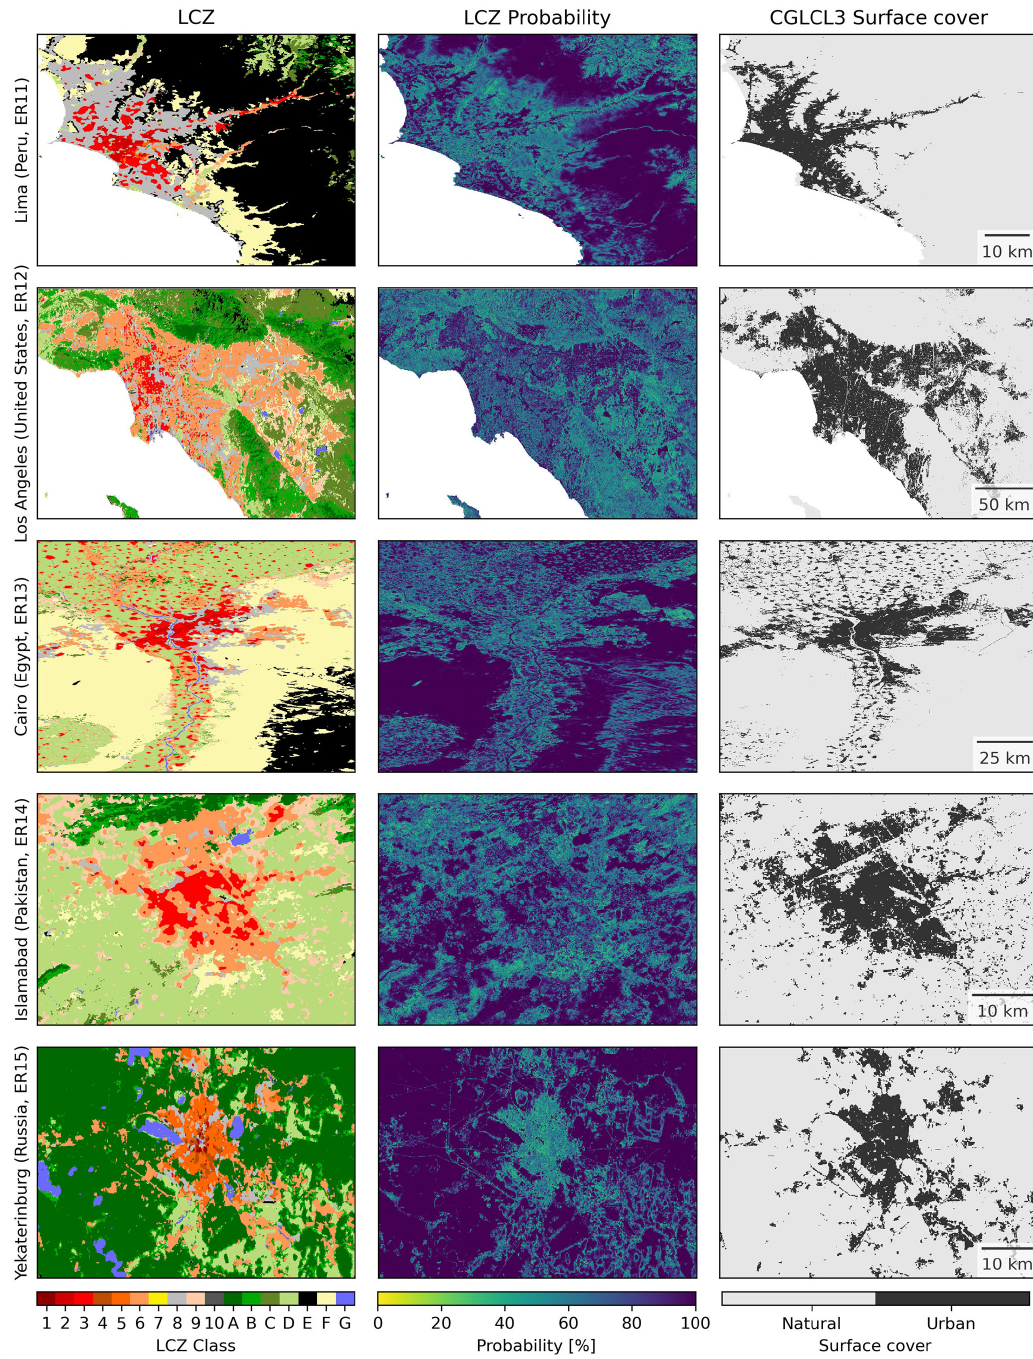
Figure 7. Like Fig. 5 but for the largest functional urban areas in urban ecoregions 11 to 15.